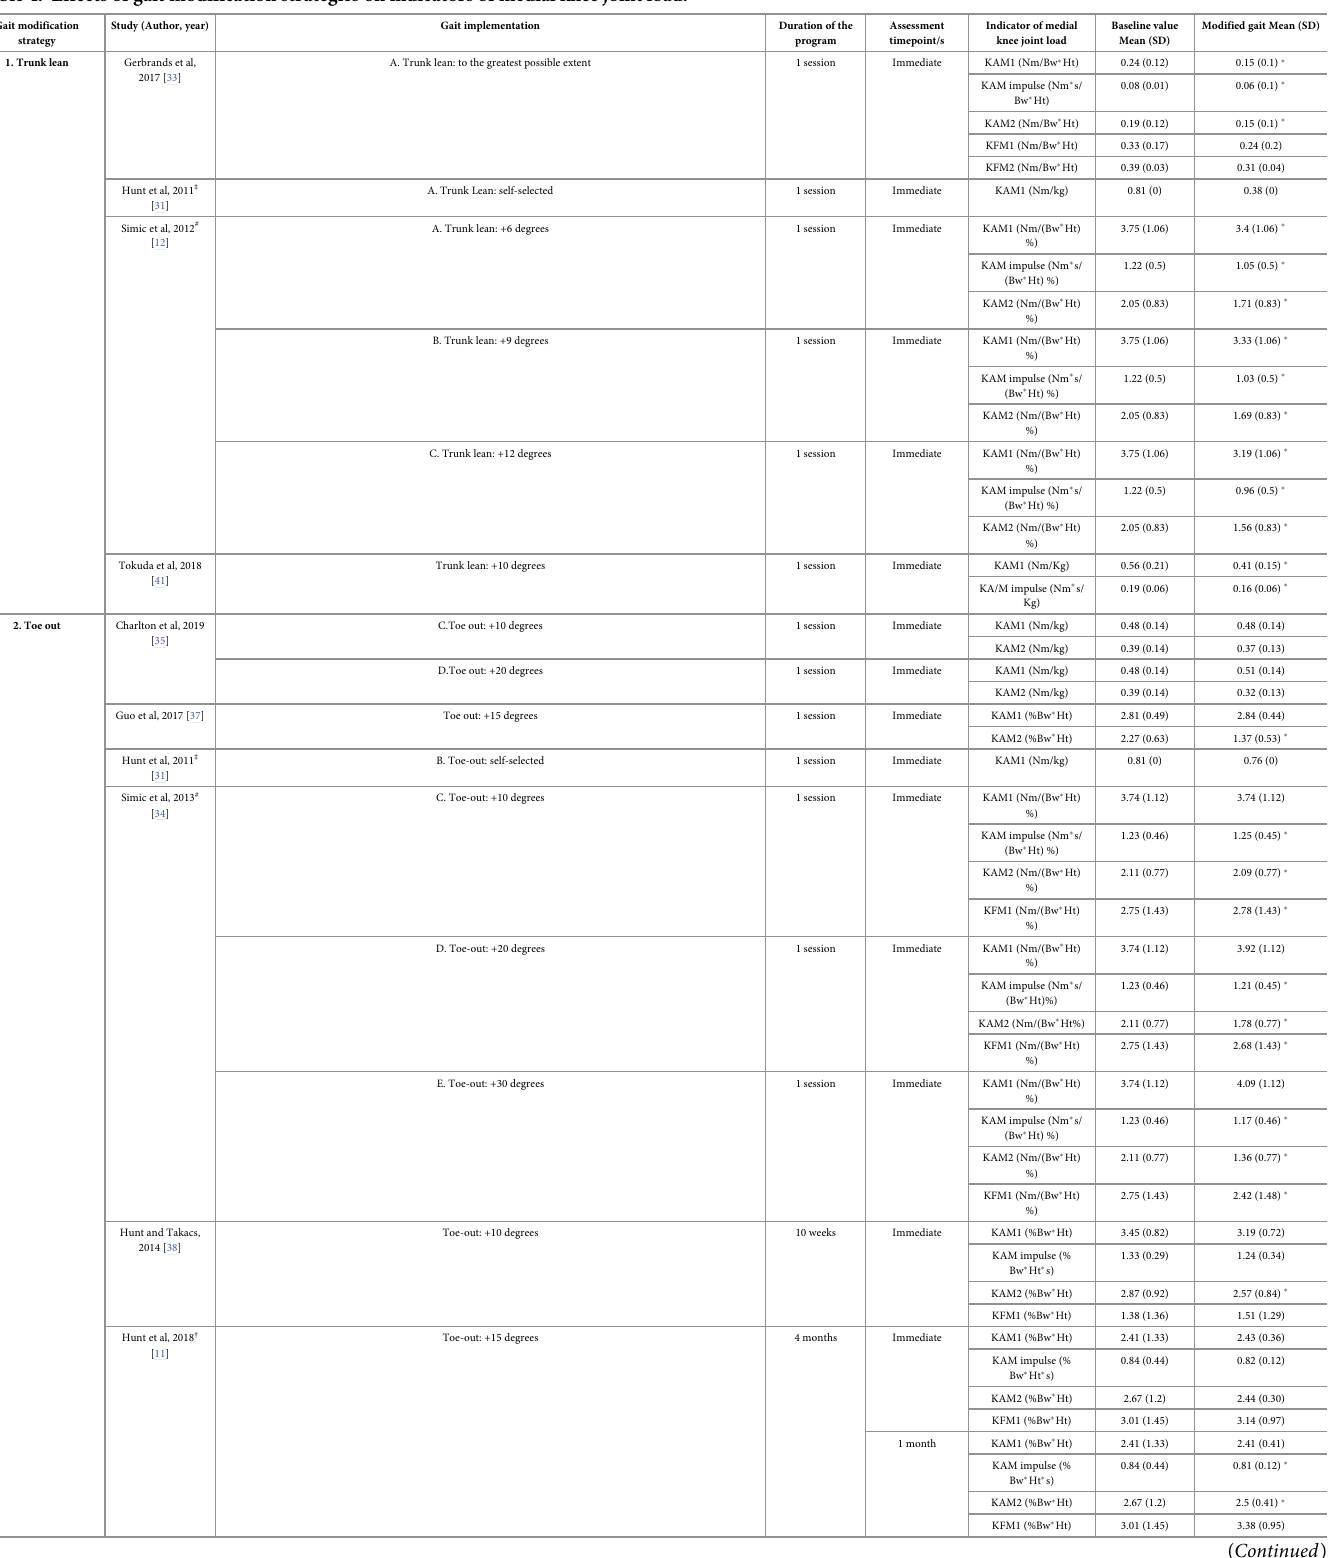
Table 4. Effects of gait modification strategies on indicators of medial knee joint